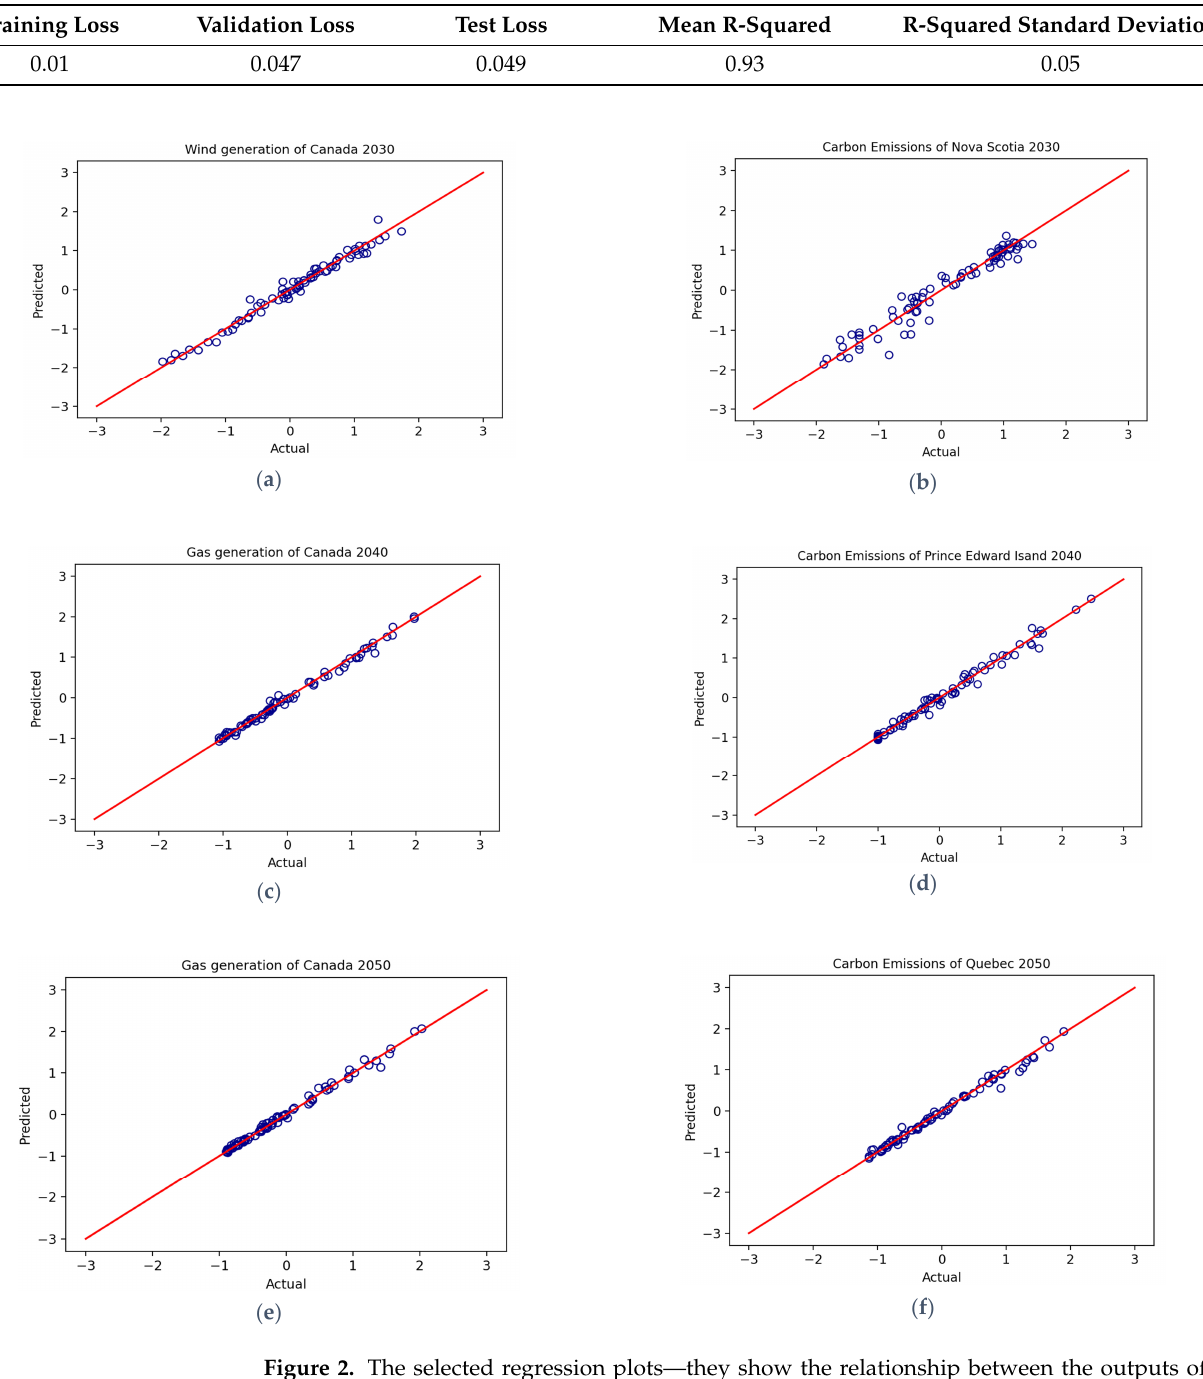
Figure 2. The selected regression plots—they show the relationship between the outputs of the proposed model and the actual values of the test data set. The x-axis represents the actual values of COPPER results, while the y-axis represents the predicted values of the surrogate model. The red line (x = y) corresponds to the highest level of accuracy, where the predicted and actual values are the same. The closer the blue dots are to the red line, the more accurate the predictions of the model are. ( a , b ) represent the lowest R-squared values among all 54 regression plots, ( c , d ) represent the average R-squared values, and ( e , f ) represent the highest R-squared values. These plots allow for visualization of the model’s performance and can be used to identify outputs where the model may not be performing as well.